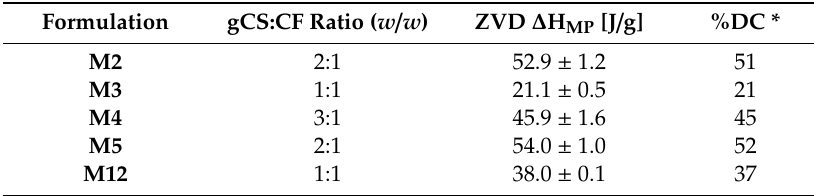
Table 4. Di ff erential Scanning Calorimetry (DSC) results of the ZVD-loaded microparticles with chitosan glutamate crosslinked with beta-glycerophosphate (gCS / CF). Formulation gCS:CF Ratio ( w / w ) ZVD ∆ H MP [J / g] %DC * M2 2:1 52.9 ± 1.2 51 M3 1:1 21.1 ± 0.5 21 M4 3:1 45.9 ± 1.6 45 M5 2:1 54.0 ± 1.0 52 M12 1:1